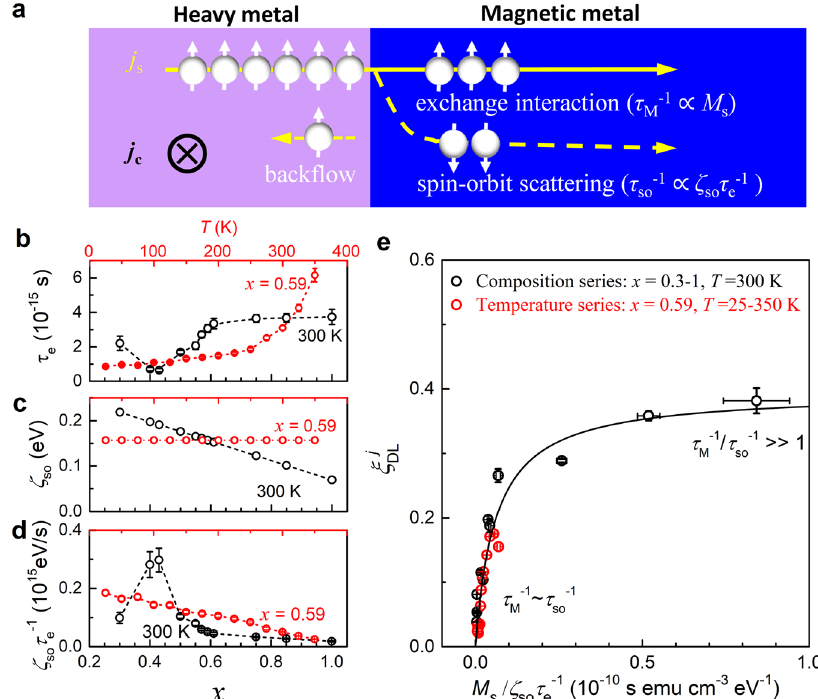
Fig. 3 | Variation of SOT with the relative spin relaxation rates. a Schematic of the spin relaxation processes that can in fl uence the SOT, highlighting the compe- tition between exchange interaction (with relaxation rate τ M − 1 ∝ M s ) and spin-orbit scattering ( τ so − 1 ∝ ζ so τ e − 1 ). Only the spin current relaxed by exchange interaction contributes to SOTs. b Momentum scattering time ( τ e ), c Estimated SOC strength